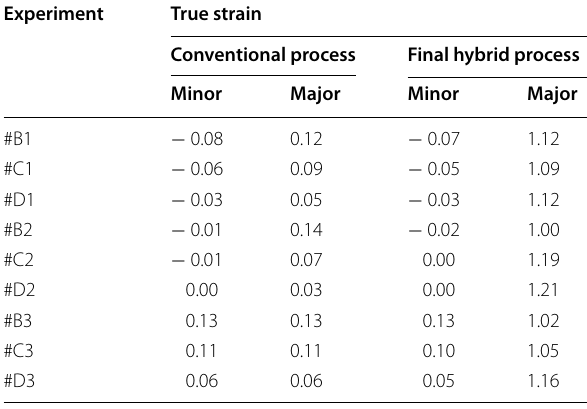
Table 4 Strains simulated in the hybrid process steps.